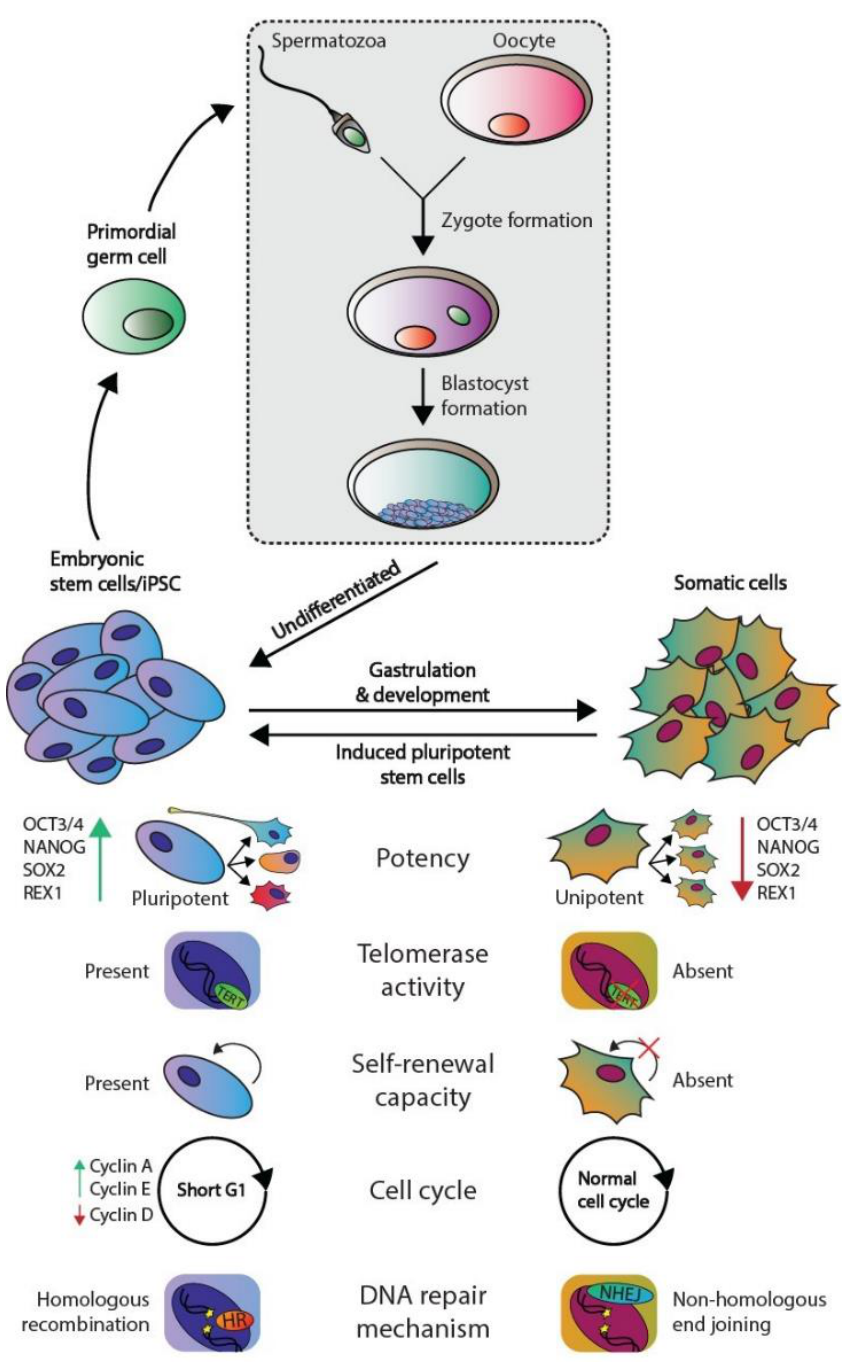
Figure 1. Phenotypic differences between embryonic and somatic cells. Fertilization of an oocyte by a spermatozoon forms a zygote, which subsequently develops the blastocyst. The blastocyst contains embryonic stem (ES) cells that eventually give rise to all somatic cell types. ES and somatic cells can be distinguished according to multiple aspects: their potency, telomerase activity, self-renewal capacity, cell cycle regulation, and preferred DNA repair mechanism. Both germ cells and germ cells tumors are derived from ES derived PGCs and therefore harbor the same embryonal